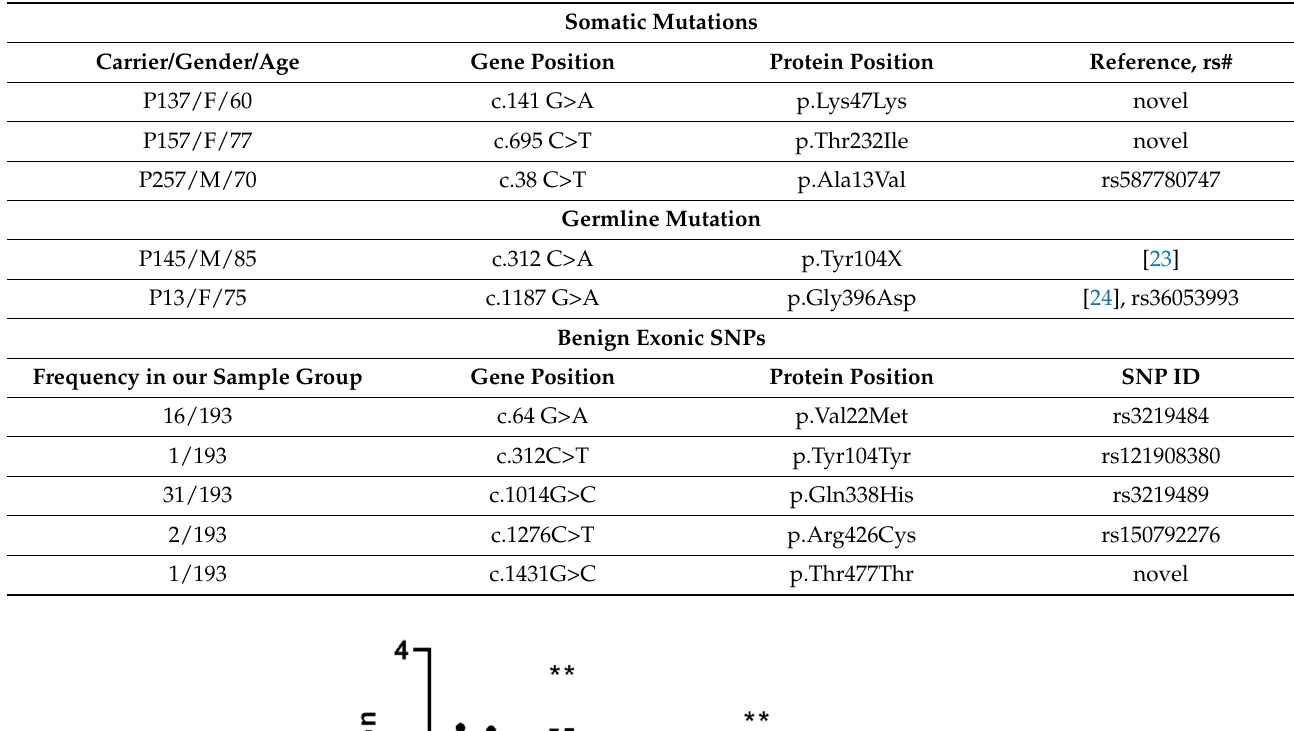
Table 2. Gene variants and somatic mutations in MUTYH gene (NM_001128425).